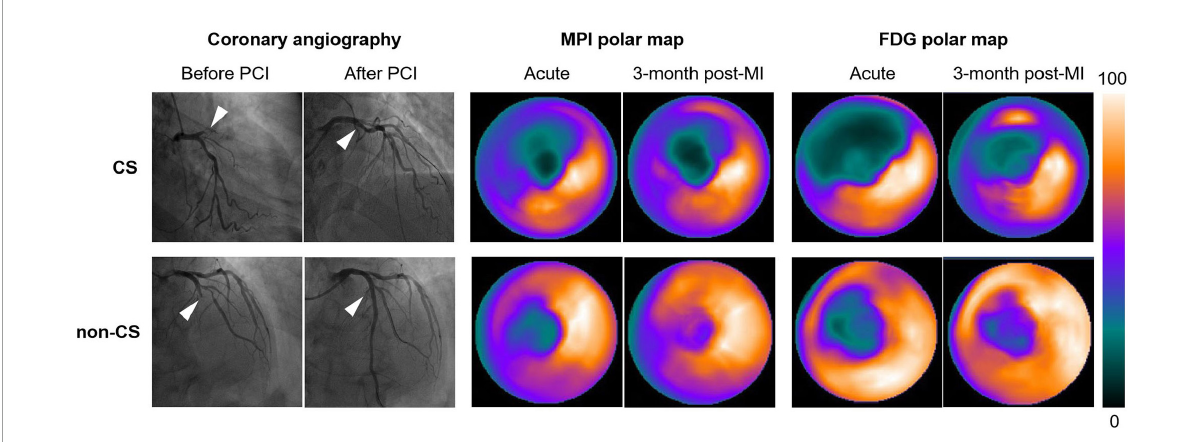
FIGURE1 Representative 99 m Tc-sestamibi/FDG images of STEMI patients with and without CS following successful PPCI in the LAD (white arrows). Polar maps identified larger extent of impaired myocardial perfusion and metabolism in patients with CS both in the acute phase and in the convalescent phase. CS, cardiogenic shock; PPCI, primary percutaneous coronary intervention; LAD, left anterior descending artery; TFD, total FDG uptake deficit.